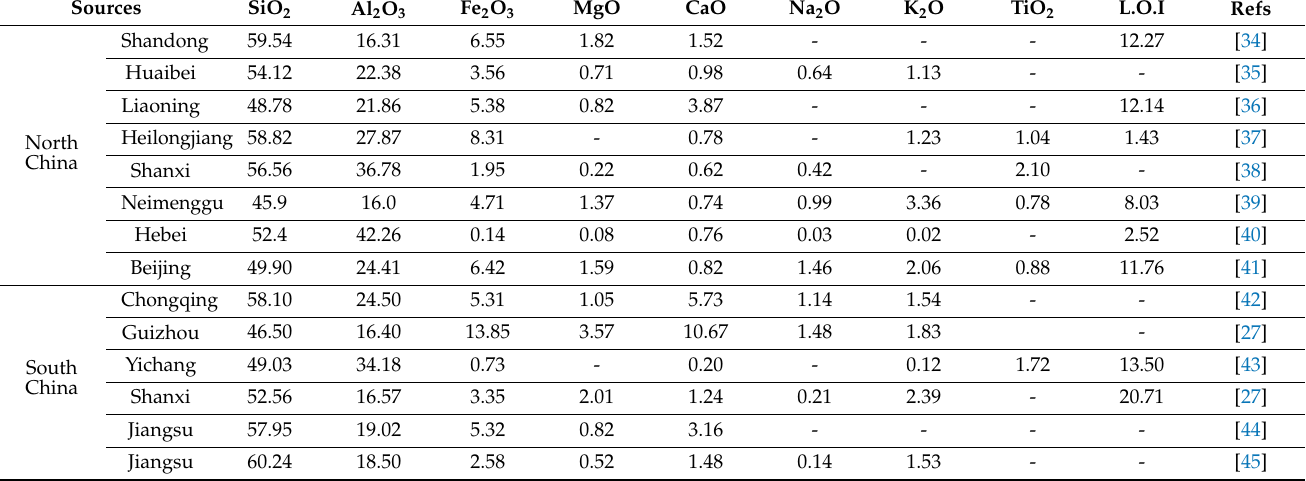
Table 3. Chemical composition of coal gangue from different